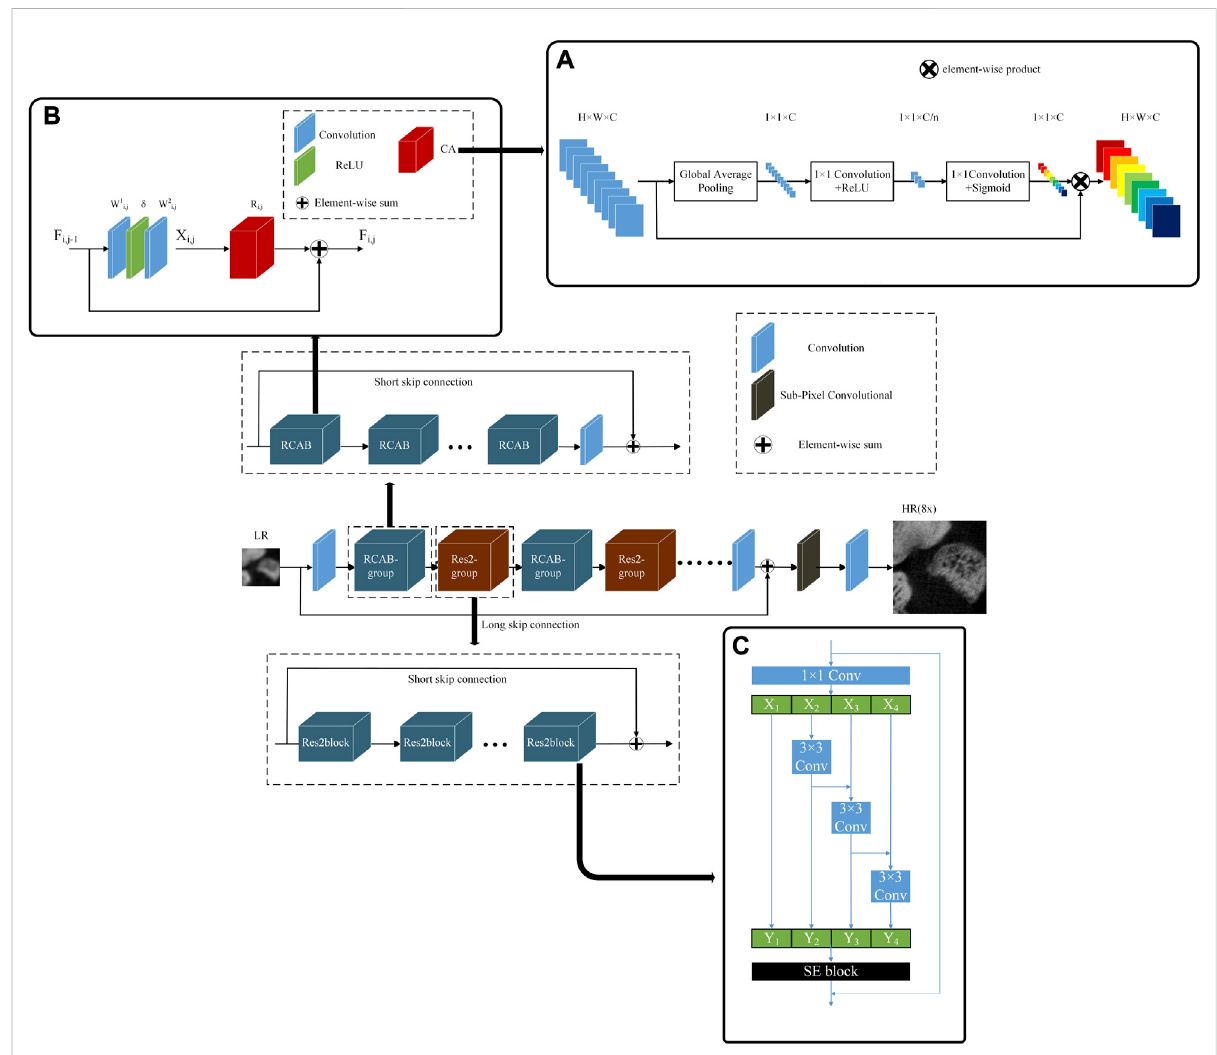
FIGURE 2 The structure of generator network R2-RCAN. (A) The structure of CA, (B) The structure of RCAB, (C) The structure of